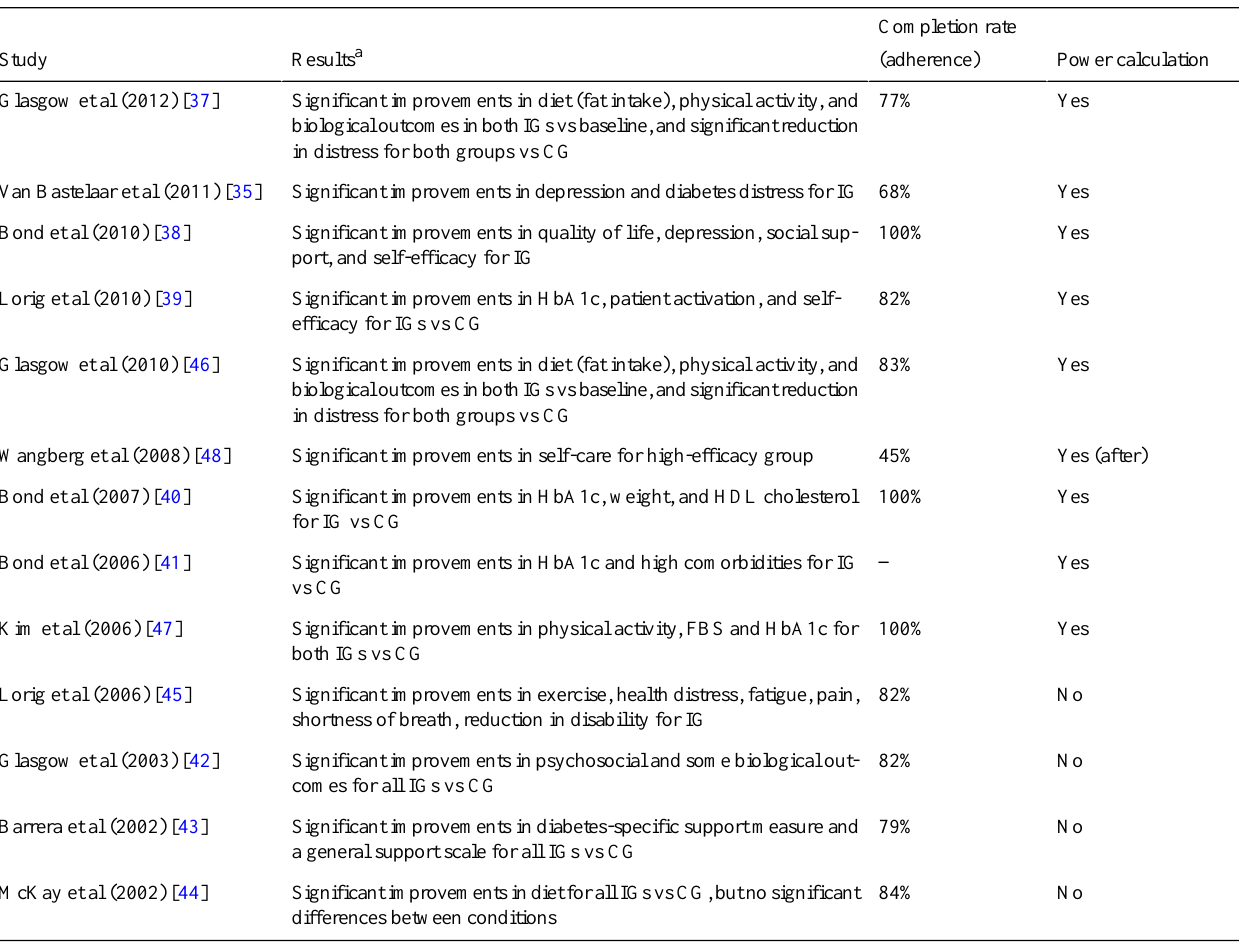
Table 2. Results of the studies.